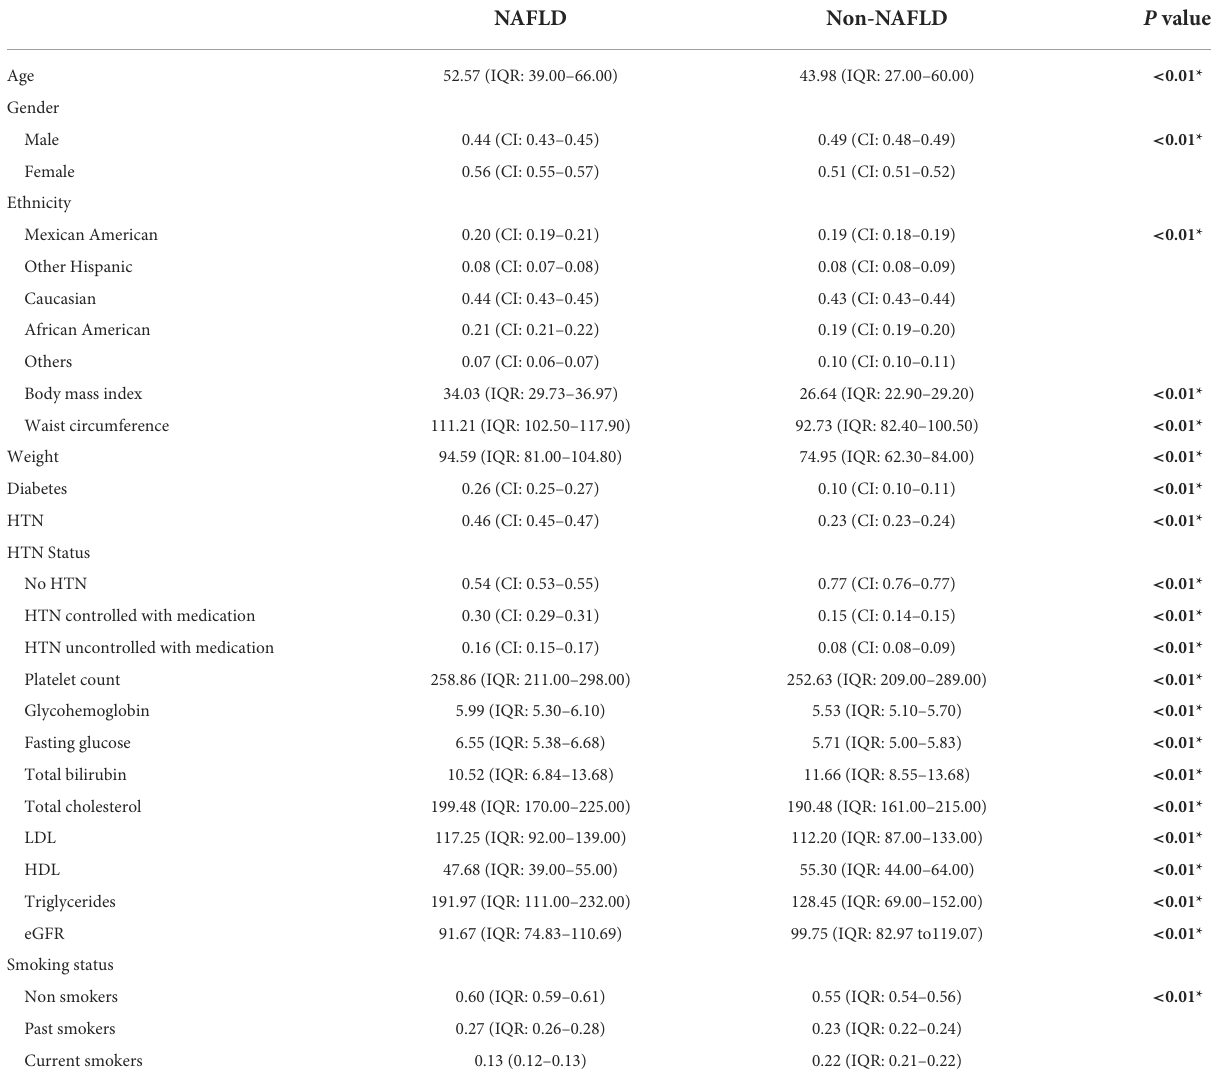
TABLE 1 Baseline characteristics between NAFLD vs.